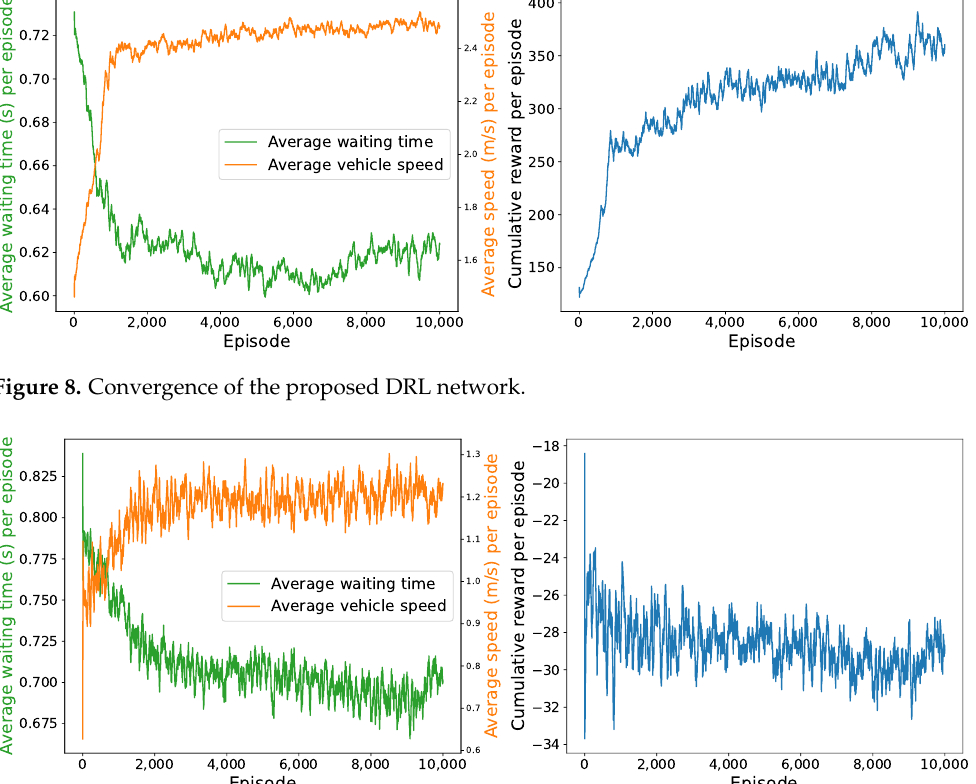
Figure 9. Training history of a reference DRL-based traffic signal